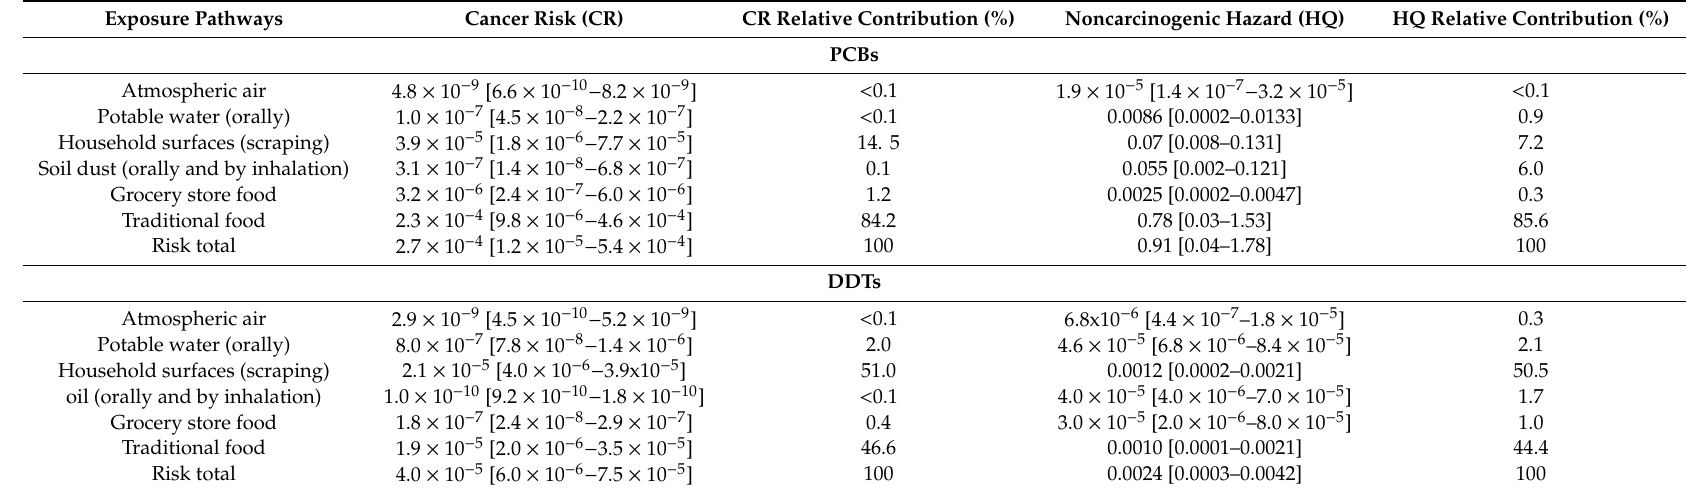
Table 1. Exposure pathway-specific health risks of polychlorinated biphenyls (PCBs) and DDTs (dichloro-diphenyl-trichloroethanes) calculated for a coastal indigenous population of Chukotka (the village of Uelen in 2001; n = 251 aged 18–71 year).